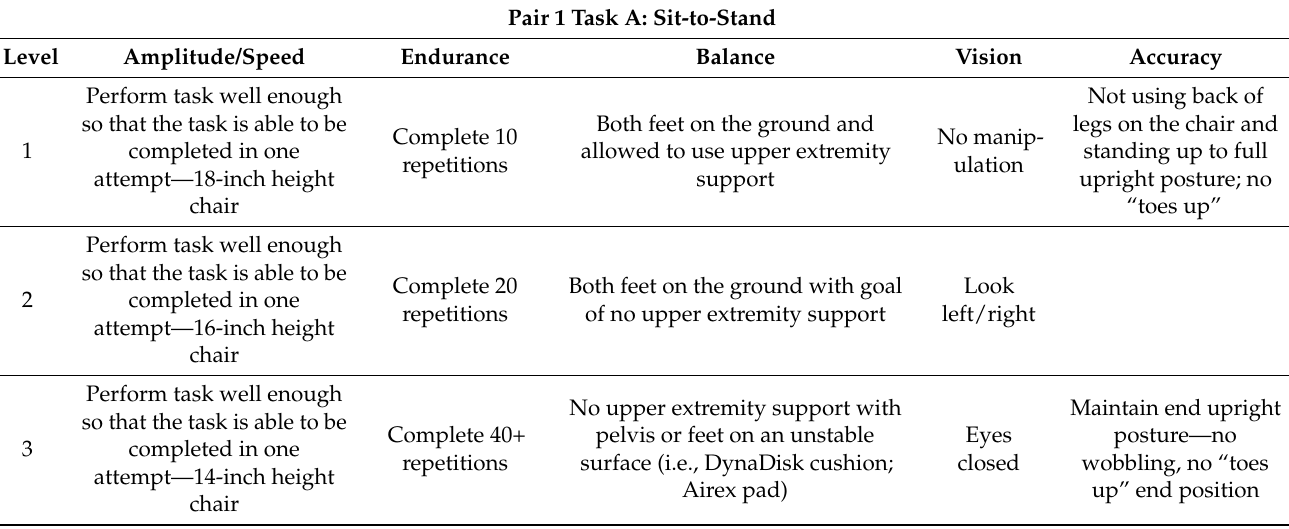
Table A3. Difficulty levels of functional tasks. Pair 1 Task A: